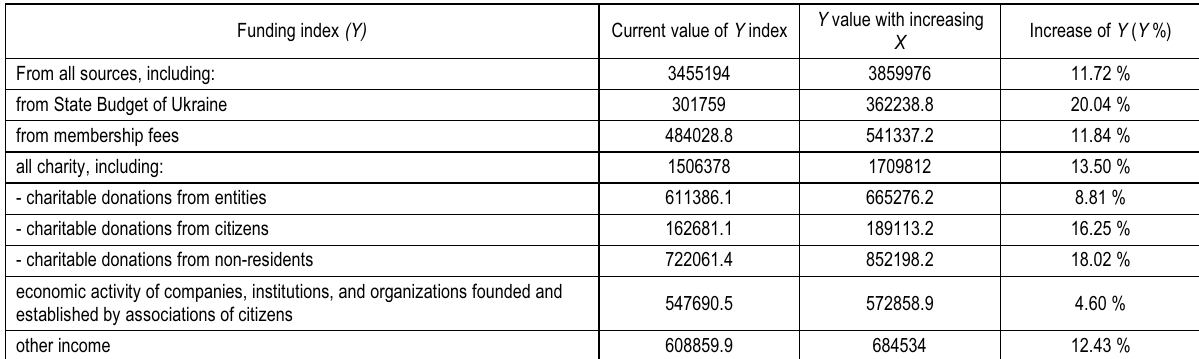
Table 12. The impact of “Number of registered members” factor on sources of funding of NGOs Funding index